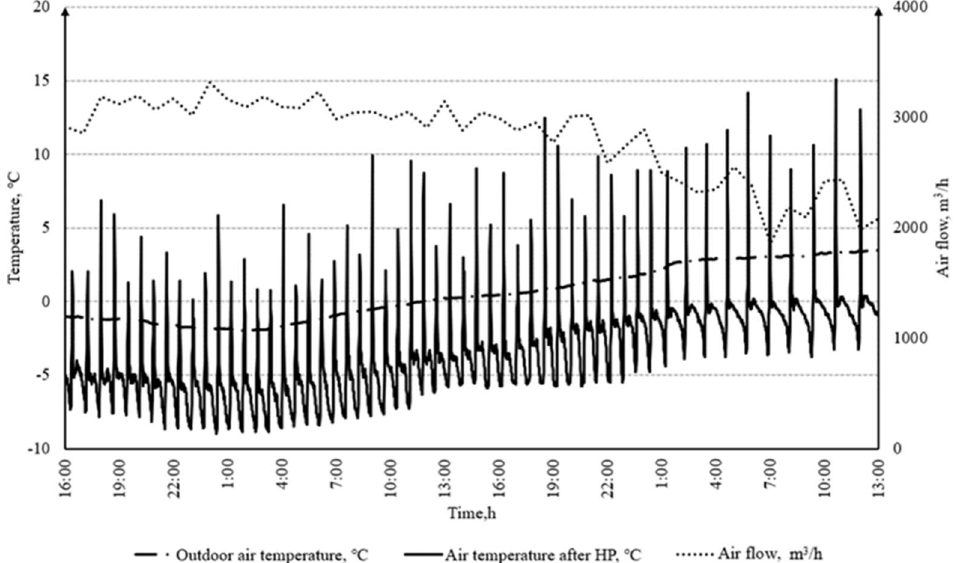
Figure 9. A comparison of the ambient air temperature with the air flow temperature after the evaporator heat exchanger and the air flow through it (15–17 December 2020).